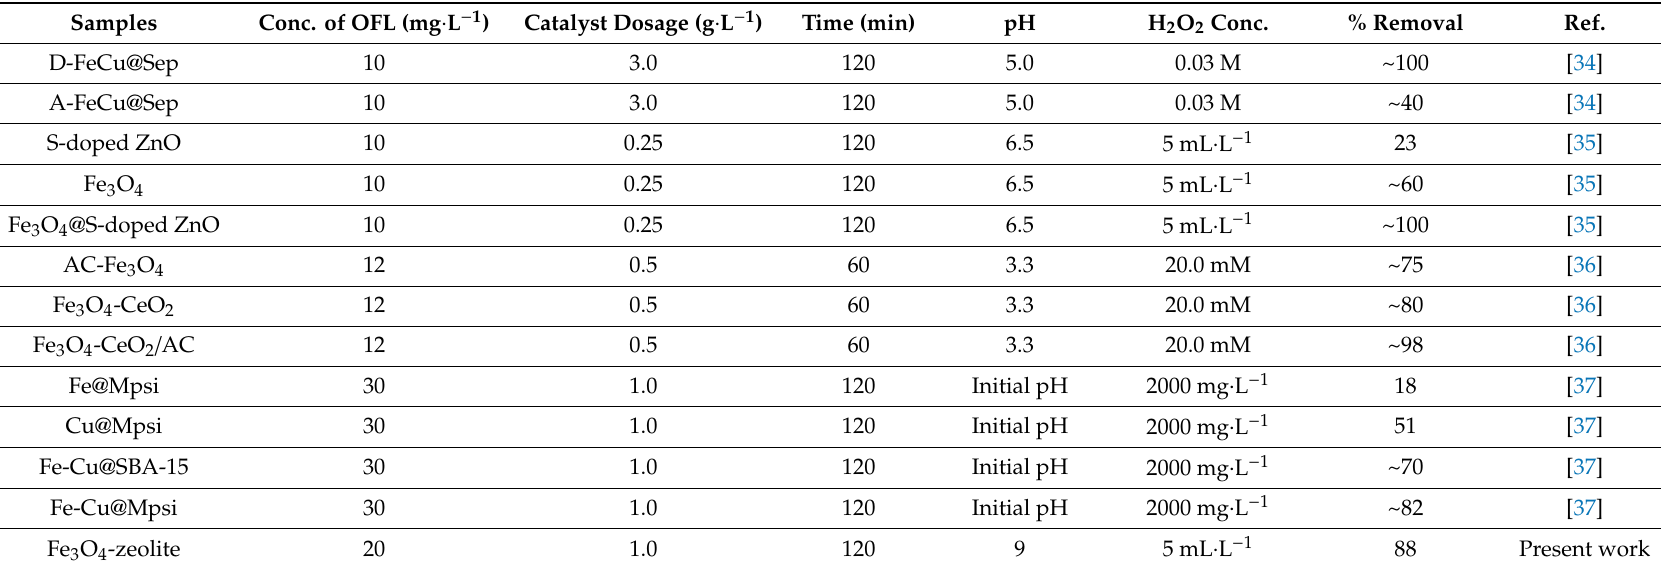
Table 3. Comparison of Fenton catalytic performance in the removal of